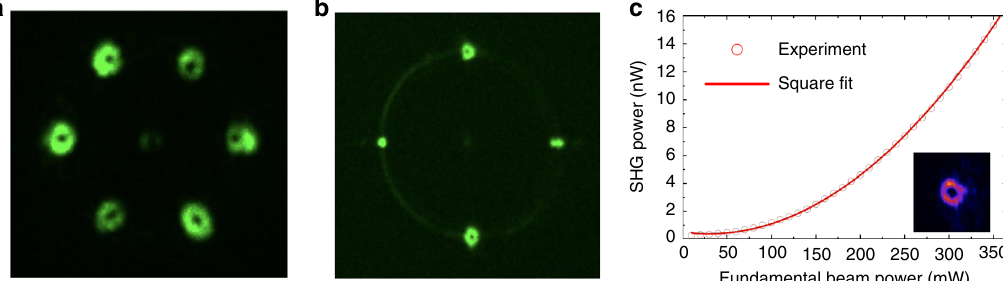
Fig. 3 Far- fi eld second harmonic patterns emitted from different nonlinear photonic crystals with optically induced and longitudinally (along fundamental beam direction) separated domain patterns. a The second harmonic pattern emitted from the three-layer fork-type nonlinear gratings mutually rotated by 60°. b The second harmonic from the 3D NPC comprising a fork grating, a one-dimensional linear grating and a circular grating, mutually rotated by 90°. c Power of the emitted SH vortex (inset) as a function of the power of fundamental beam. Here the wavelength of the fundamental beam was 1600 nm. The colors of the second harmonic in the fi gures are false and are used for better